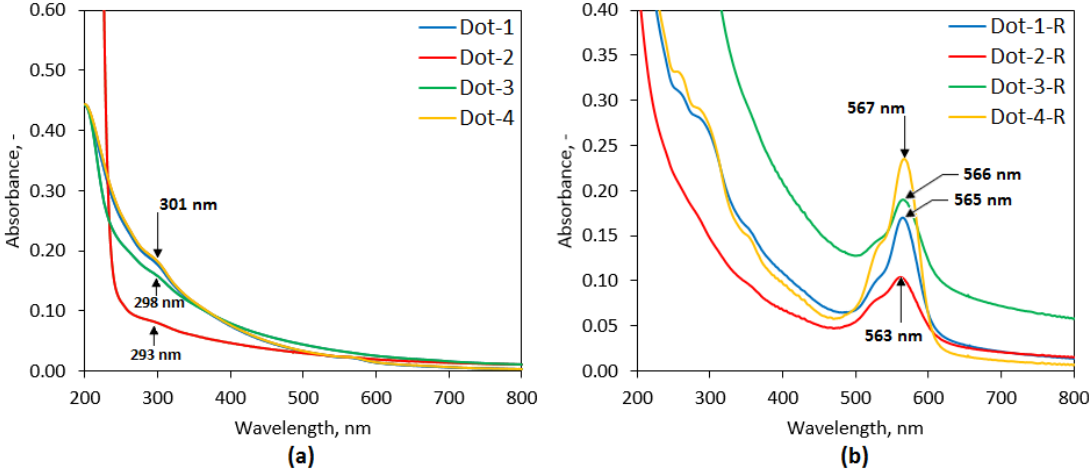
Figure 5. ( a ) UV – VIS spectra of the prepared CQDs from glucose; ( b ) UV – VIS spectra of the CQDs Figure 5. ( a ) UV–VIS spectra of the prepared CQDs from glucose; ( b ) UV–VIS spectra of the CQDs modified with Rhod-OH . modified with